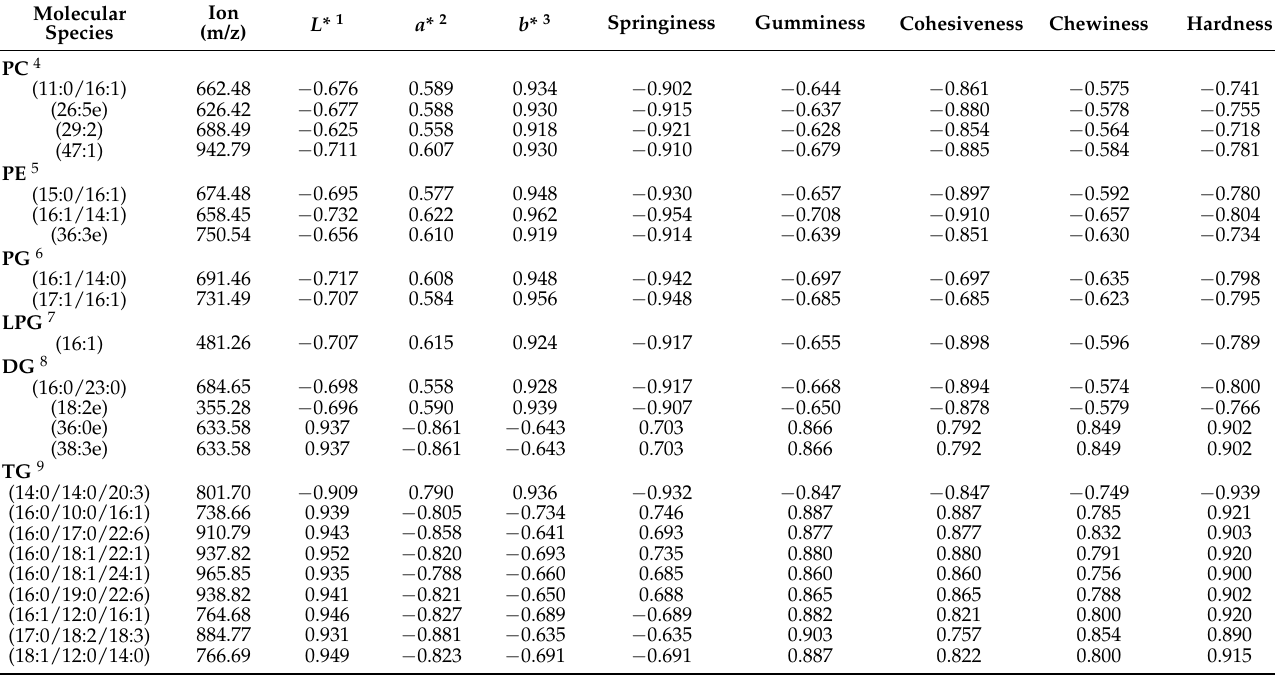
Table 3. Pearson’s correlation between significantly different lipid molecular species (R 2 > |0.9|, n ≥ 2) and quality characteristics of L. vannamei after low-temperature